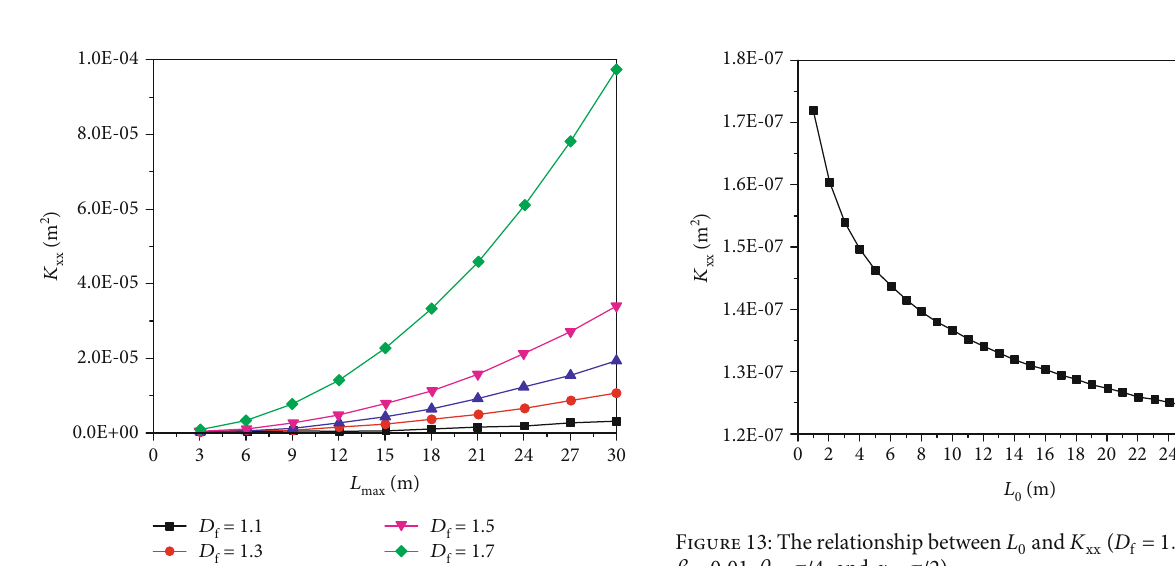
Figure 10: The relationship between K β = 0 : 01 , and α = π /4